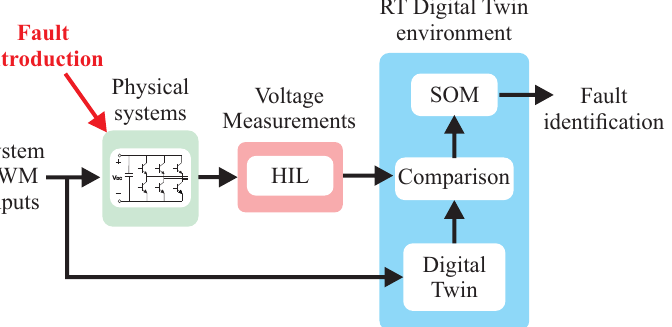
Figure 4. Proposed real-time neural network and digital twin-based fault identification